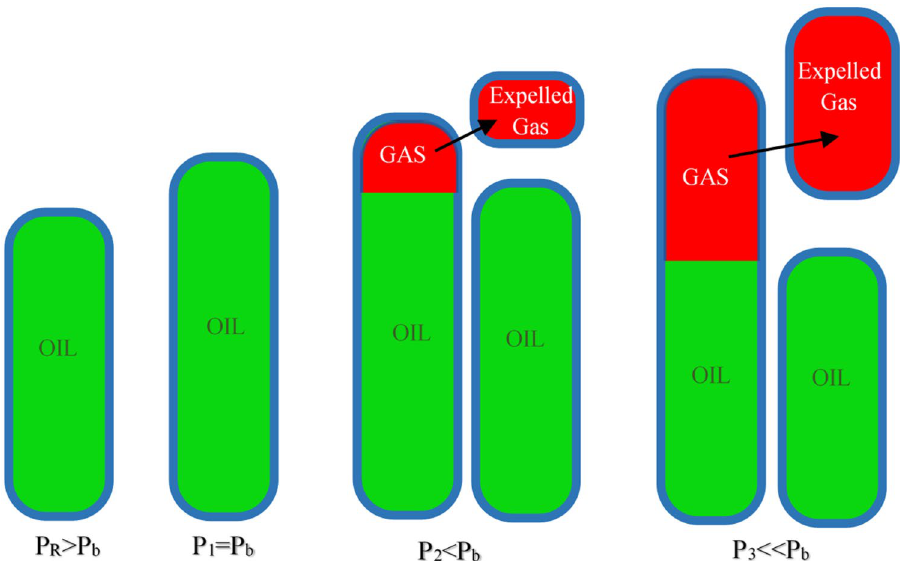
Fig. 2 Differential liberation experiment